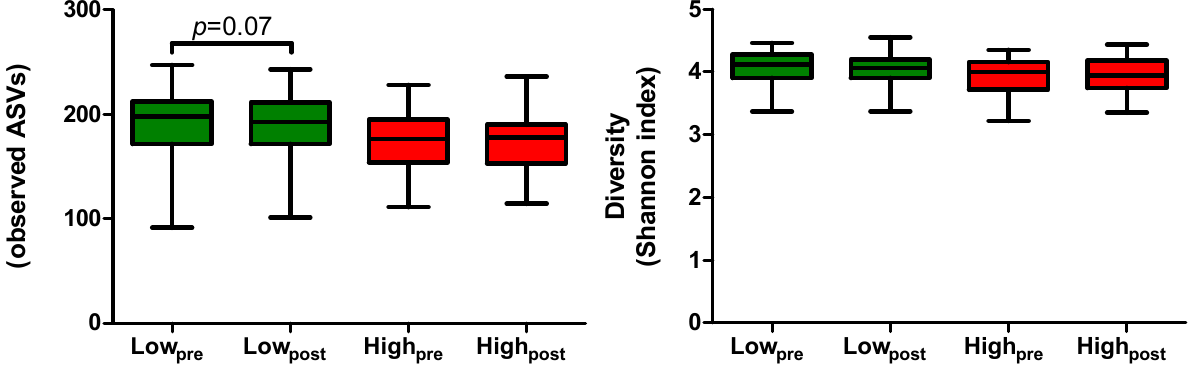
Figure 2. Richness ( left ) and gut microbial diversity ( right ) before and after a 4-week diet low or high in AGEs. Sample sizes: low-AGE group n = 34, high-AGE group n = 36. Within-group differences were tested with a paired samples t -test. Treatment effects were tested with a one-way ANCOVA with adjustment for age, sex, and the baseline variable of interest.